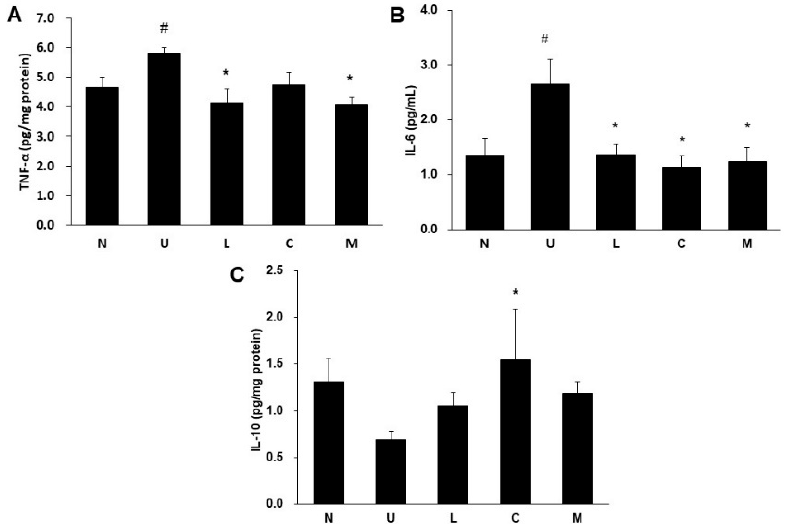
Figure 5. Effects of Lycium barbarum polysaccharides (LBP) and capsaicin (CAP) on ( A ) Colonic tumor necrosis factor- α (TNF- α ), ( B ) Serum interleukin-6 (IL-6), and ( C ) Colonic interleukin-10 (IL-10).